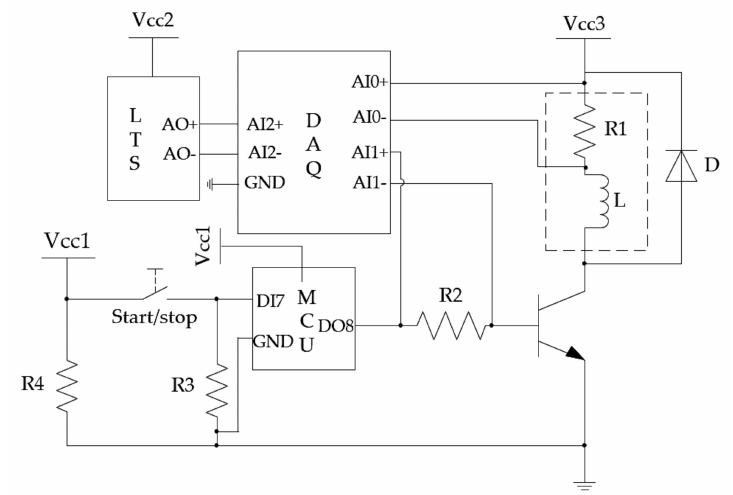
Figure 5. Circuit diagram of measurement and control system.